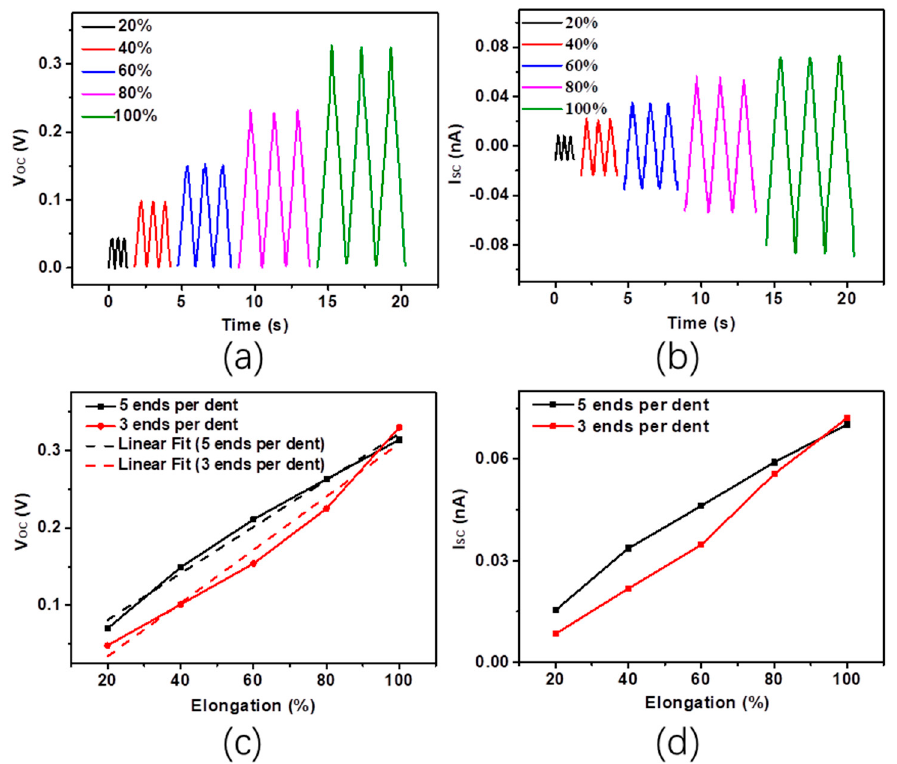
Figure 5. ( a , b ) The electrical output performances of the 3DWE-TENG with warp yarn density 417 ends/10 cm; ( c , d ) The electrical output performances comparison between two 3DWE-TENGs with different warp yarn densities, including five ends per dent and three ends per dent.